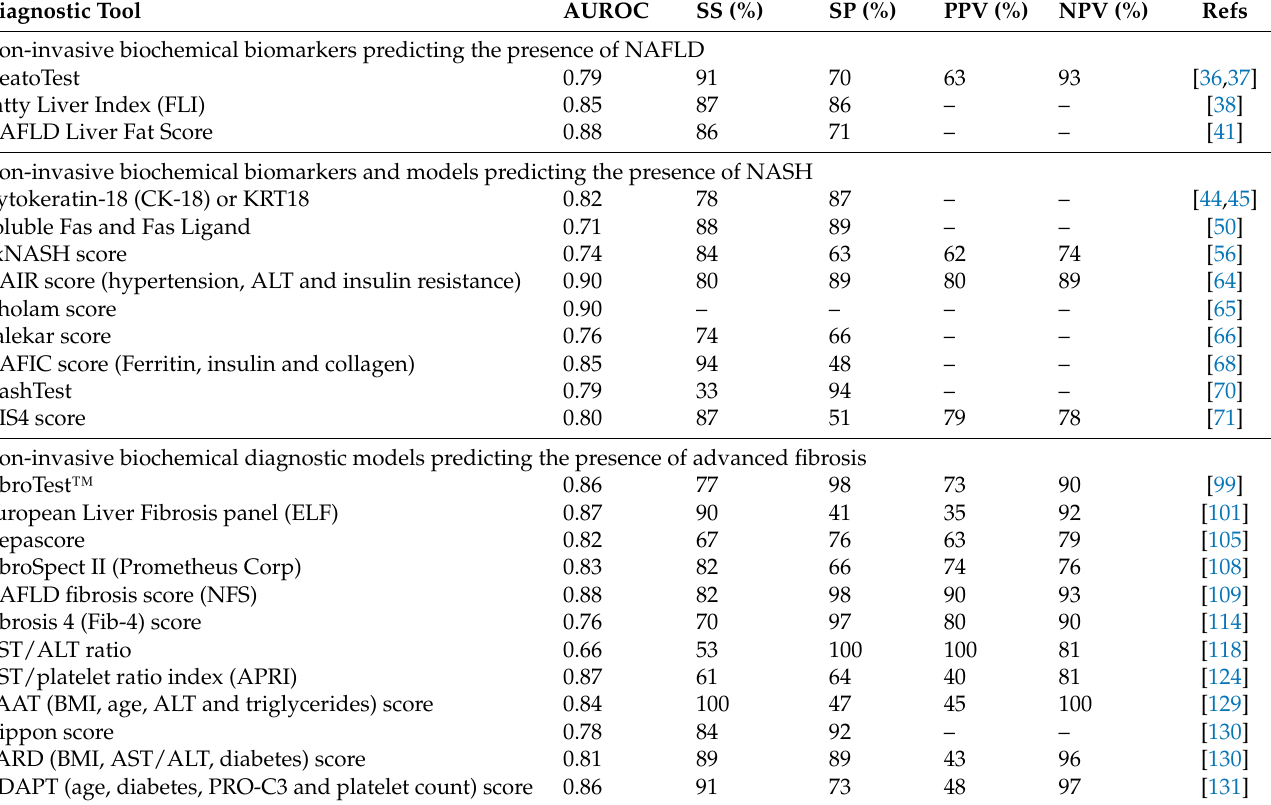
Table 1. Non-invasive biochemical diagnostic models for predicting the presence of NAFLD, NASH and advanced fibrosis. The table includes proprietary and non-proprietary